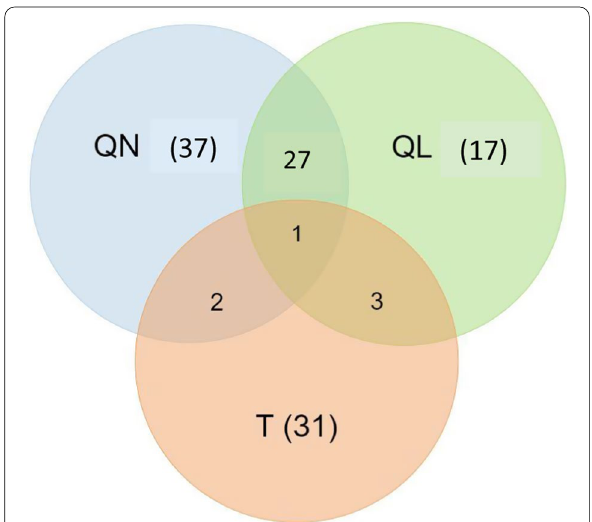
Fig. 9 Venn diagram for QN (quantitative), QL (qualitative), and T (technical) types of